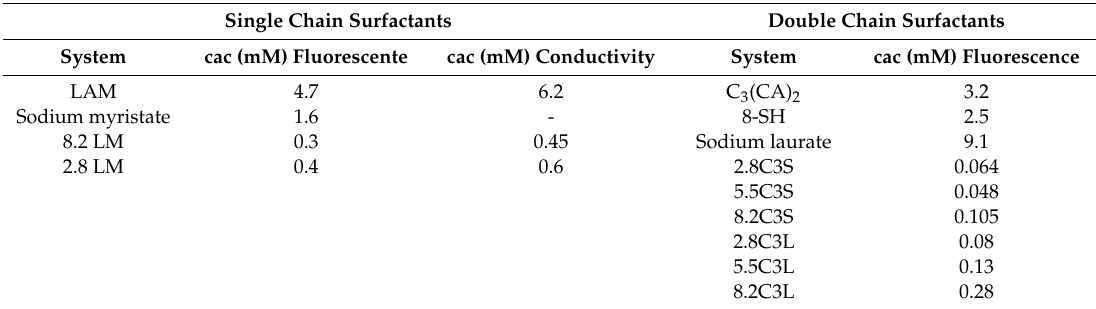
Table 2. Critical aggregation concentration (cac) of pure surfactants and their catanionic mixtures.